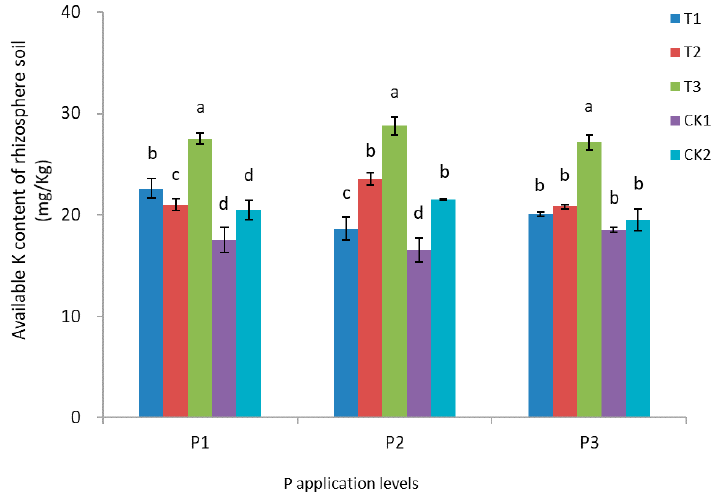
Figure 3. Effects of PSB on the available potassium content of C. oleifera . Note: Data are means ± SD ( n = 3). Different lowercase letters within the same column indicate significant differences ( p ≤ 0.05).